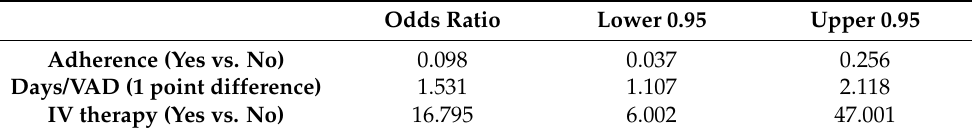
Table 4. Multivariable model for the occurrence of complications. Odds Ratio Lower 0.95 Upper 0.95 Adherence (Yes vs. No)